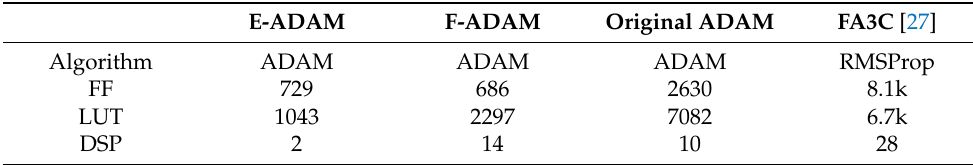
Table 1. The resource consumption of the proposed design.